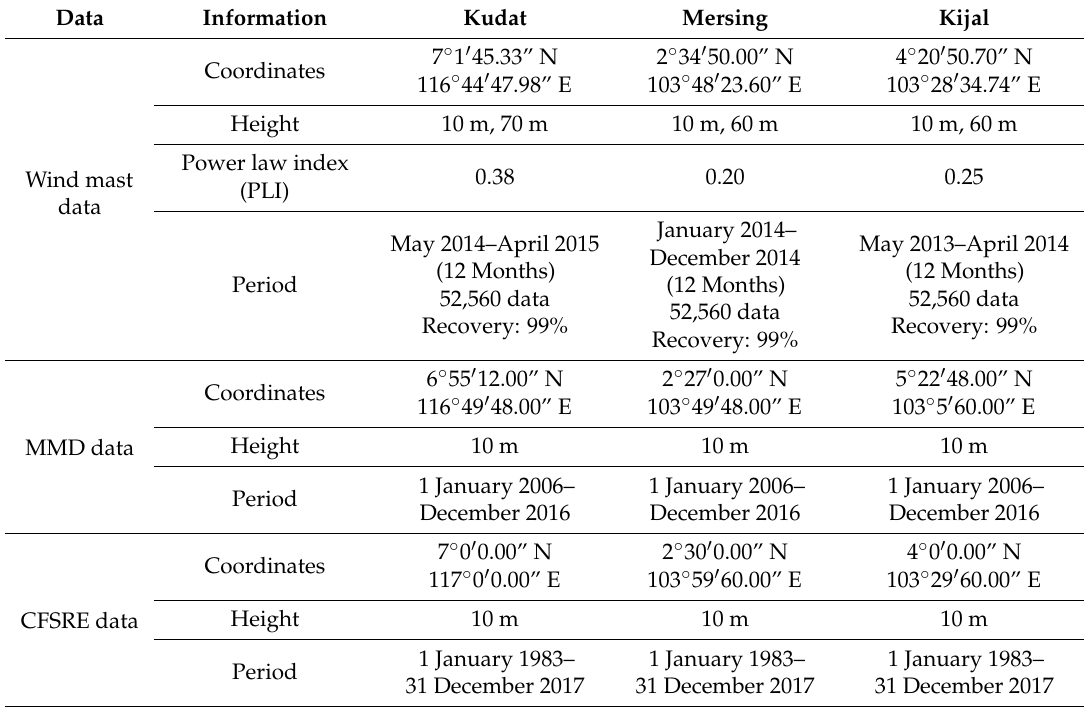
Figure 1. Map showing the selected sites. Table 1. The sites of the measured wind mast, the Malaysia Meteorological Department (MMD) and Climate Forecast System Reanalysis (CFSRE).